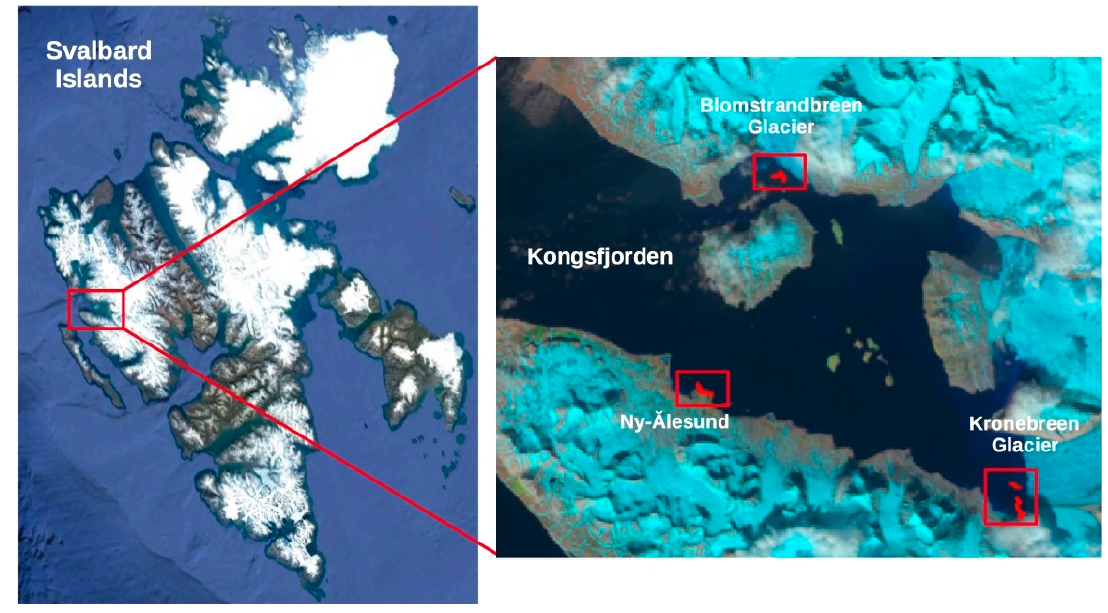
Figure 6. Study area and transects trajectories performed by PROTEUS vehicle.